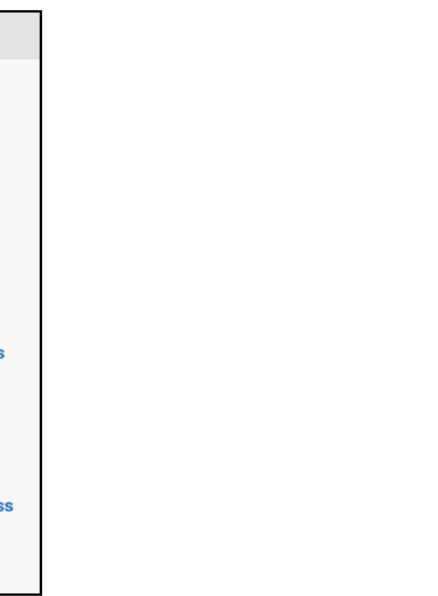
Figure 2. mSMART home